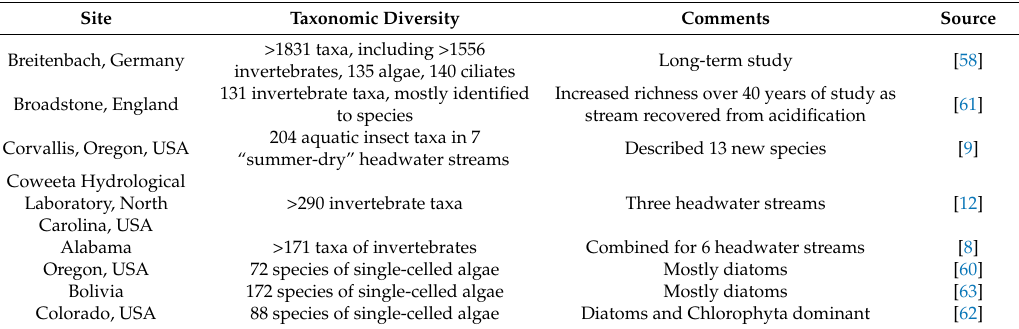
Table 3. Examples of the taxon richness in studies of headwater